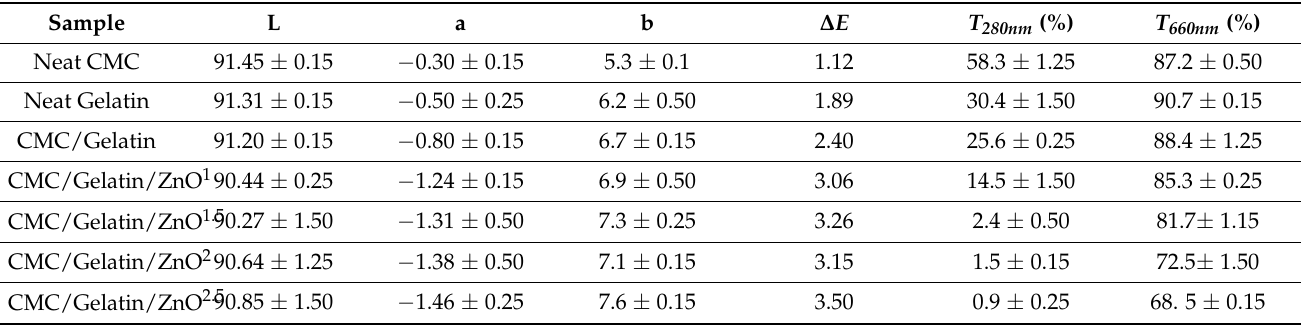
Table 2. Optical data of CMC/gelatin/ZnO composite films loaded with different contents of